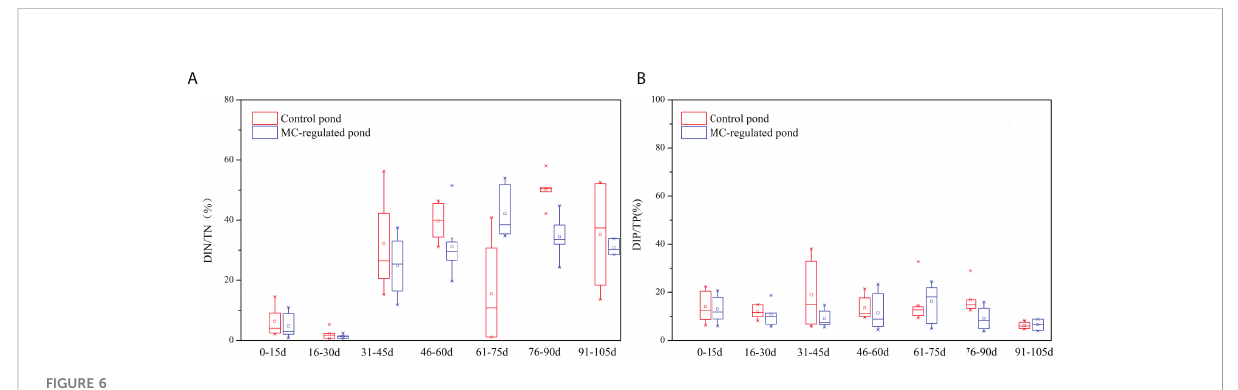
FIGURE 6 Temporal variations in (A) DIN/TN and (B) DIP/TP